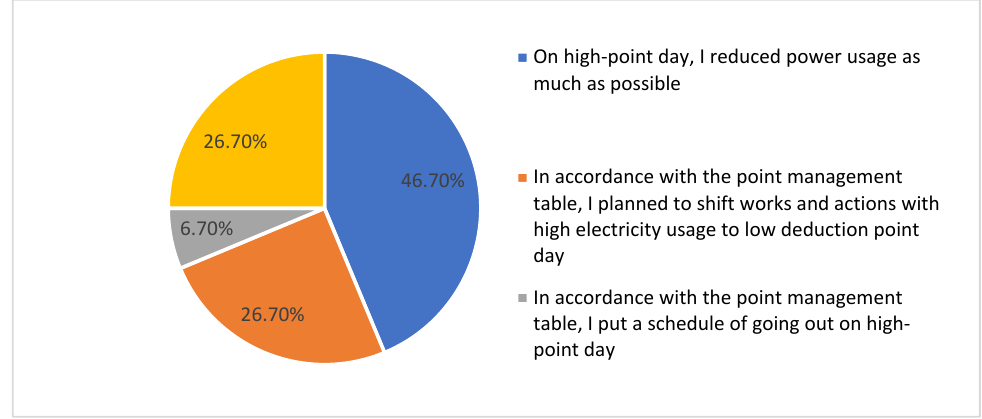
Figure 9. Household response to the question “What kind of energy ‐ saving activities did you do?”.